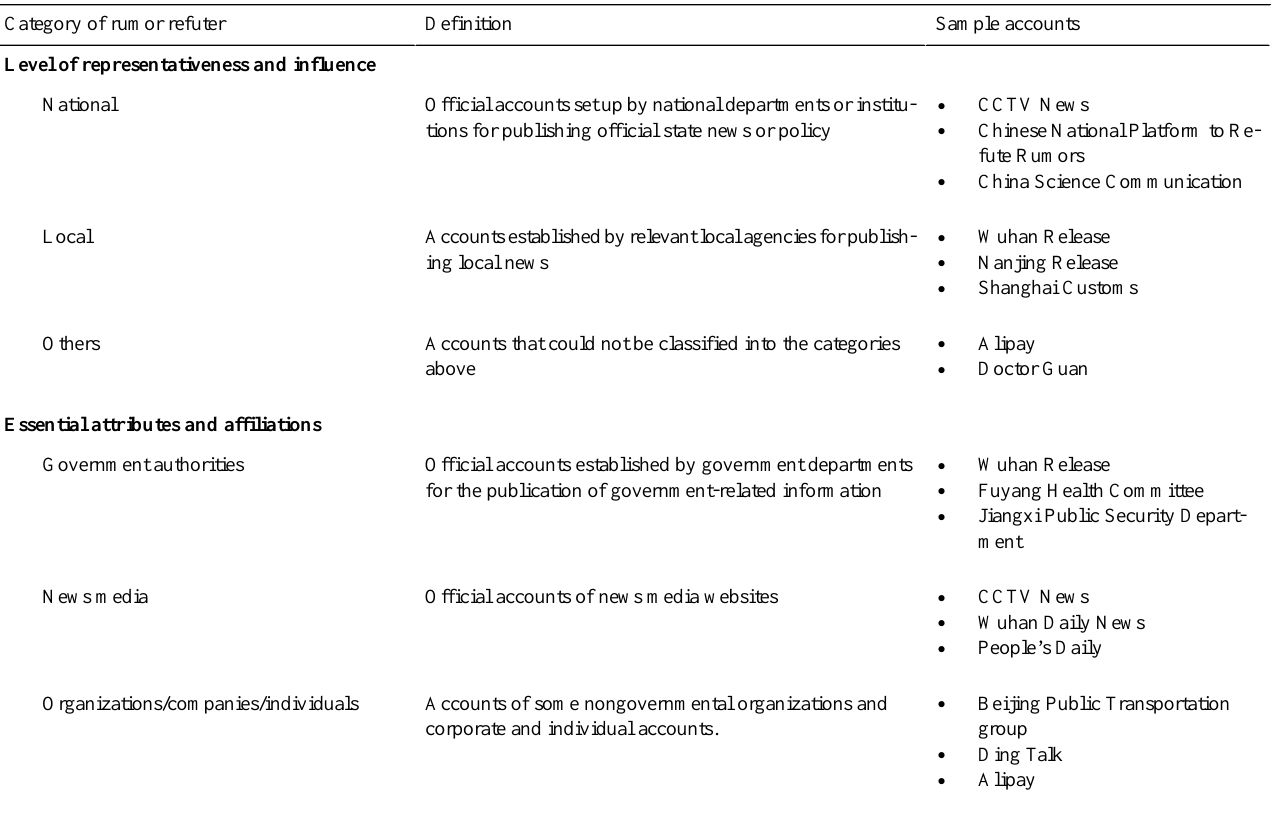
Table 1. The criteria of the categories for the rumor refuters and the sample